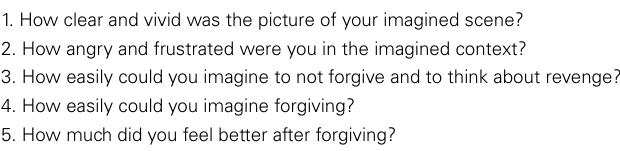
Table 2 | Self-rating questionnaire on imaginative